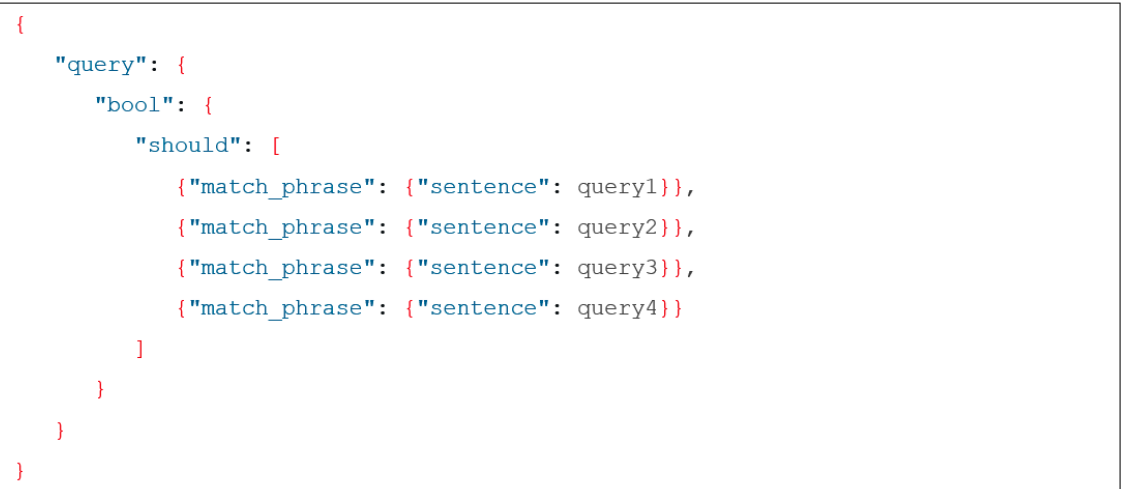
Figure 9. A bool query combining queries given in Table 1.